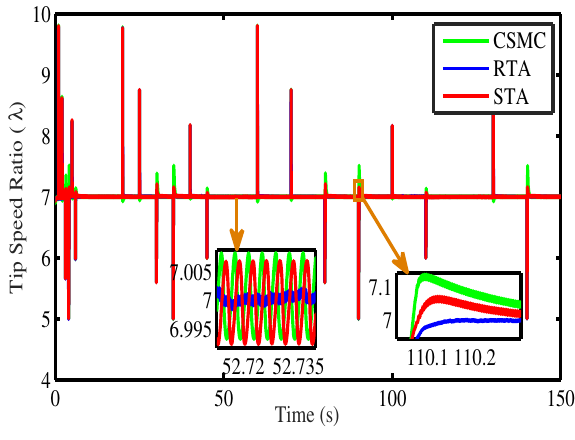
Figure 16. PMSG side angular speed.